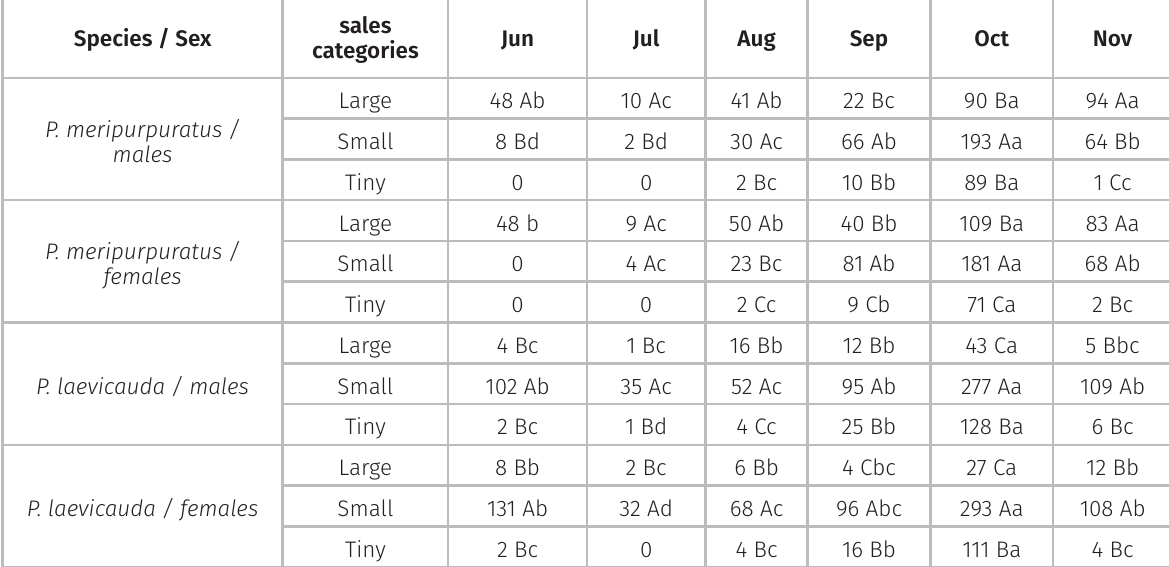
Table II. Multinomial proportions of the species collected, by sex, in the sampling months and according to the regional commercial